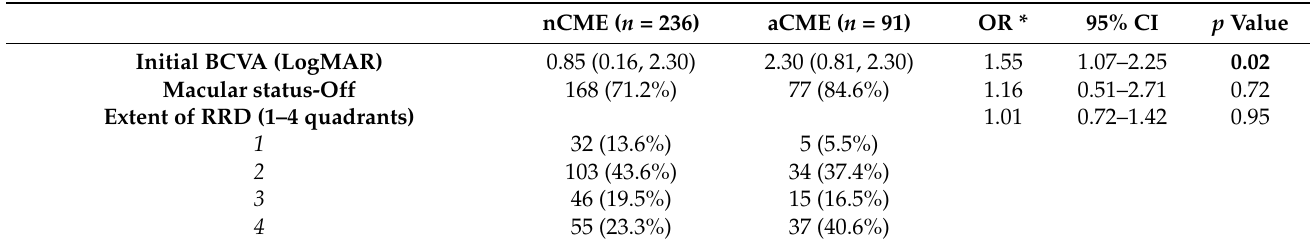
Table 3. Risk factors for cystoid macular edema at 12 months-multivariate